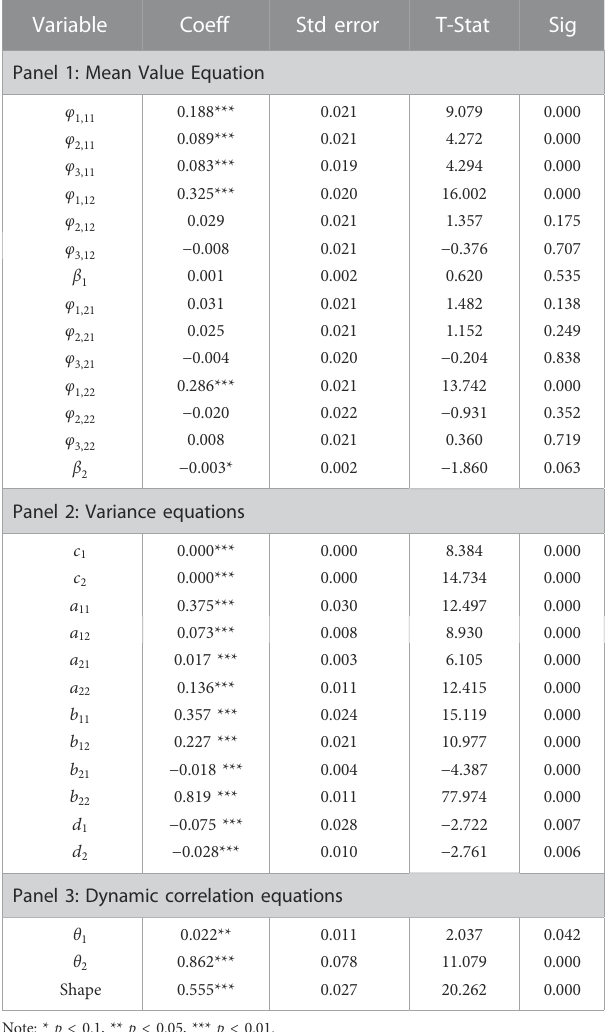
TABLE 5 Estimation results of the parameters of the VECM-DCC-VARMA- AGARCH model. Variable Coeff